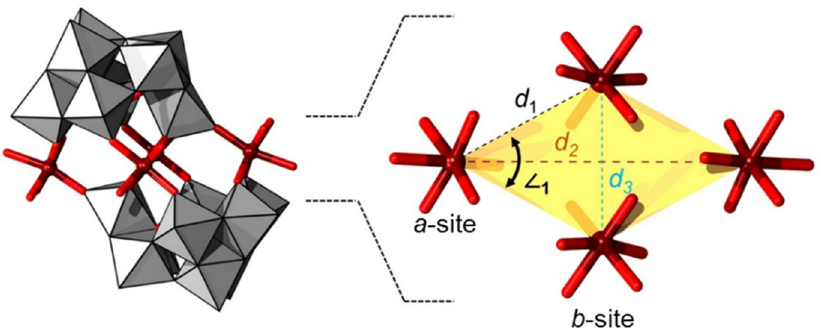
Figure 4. Offset/Krebs-type sandwich archetype {M 4 O 10 ( β -XW 9 O 33 ) 2 } ( left ) and its central rhomboidal core ( right ) emphasizing the different a - and b -sites and d 1 , d 2 and d 3 interatomic distances. Color code: X = green (but covered), M = brown, {WO 6 } = gray octahedra, and O = red.